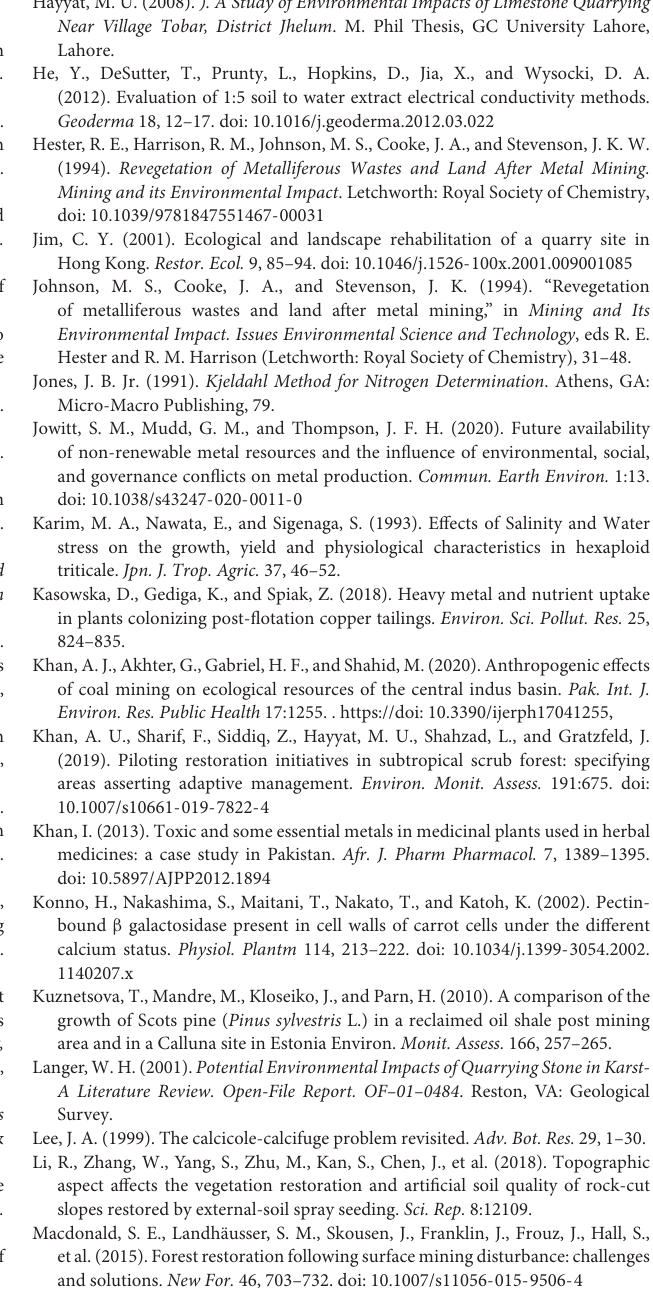
Supplementary Figure 1 | Effect of quarry waste on plant height (cm) of Acacia modesta over time. The asterisks indicate the significant difference of treatment means with the control ( T 0 ): ∗ P < 0.05, ∗∗ P < 0.01, and ∗∗∗ P < 0.0001.